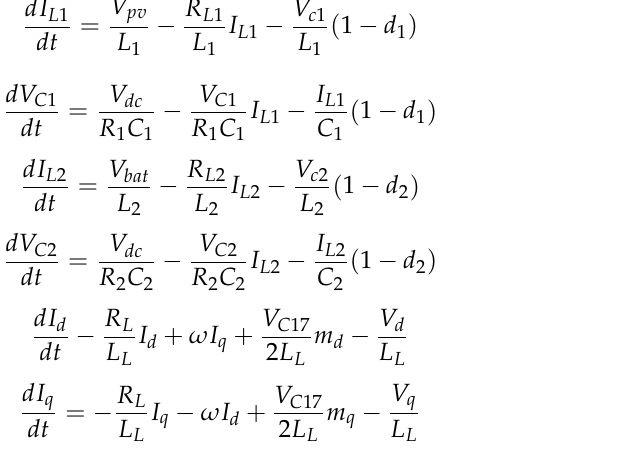
Figure 11. Generated Pulse for